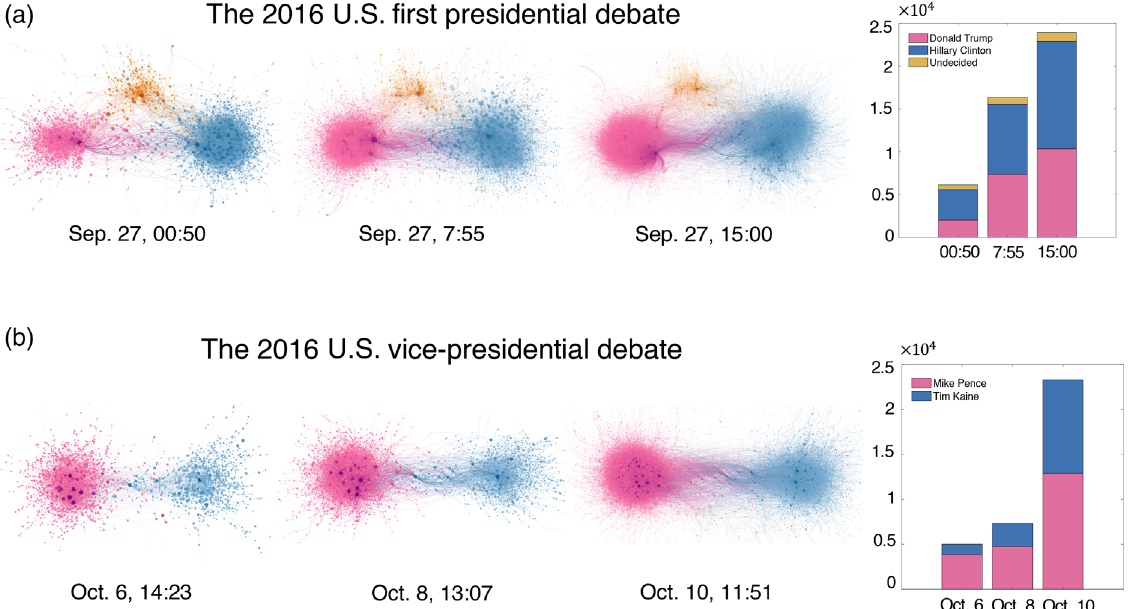
FIG. 1. Evolving echo chambers in core retweet networks. The progression of echo-chamber formation in retweet networks during time frames surrounding (a) the first 2016 U.S. presidential debate and (b) the 2016 U.S. vice presidential debate. In each network subfigure on the left, the nodes represent users, node colors show the nodes cluster, the edges indicate retweets, and node size and color intensity reflect a node ’ s retweet volume. The bar charts on the right show the growth of support for each candidate during two of the 2016 debates. In (a), the red nodes indicate individuals who tend to support Donald Trump, while blue ones indicate Hillary Clinton supporters. The yellow cluster shows users who are mainly retweeting unaligned users or supporters of both sides. The dataset begins at 17 ∶ 45 on September 26, and the final graph includes 54840 edges. In (b), the networks are divided into two polarized echo chambers: The red cluster shows Mike Pence (Trump ’ s vice president) supporters, and the blue cluster shows Tim Kaine (Clinton ’ s vice president) supporters. Unlike the first presidential debate, there is not a cluster of undecided supporters, despite both graphs being roughly the same size in terms of nodes and edges. The dataset begins at 15 ∶ 40 on October 4, 2016, and the final graph includes 55008